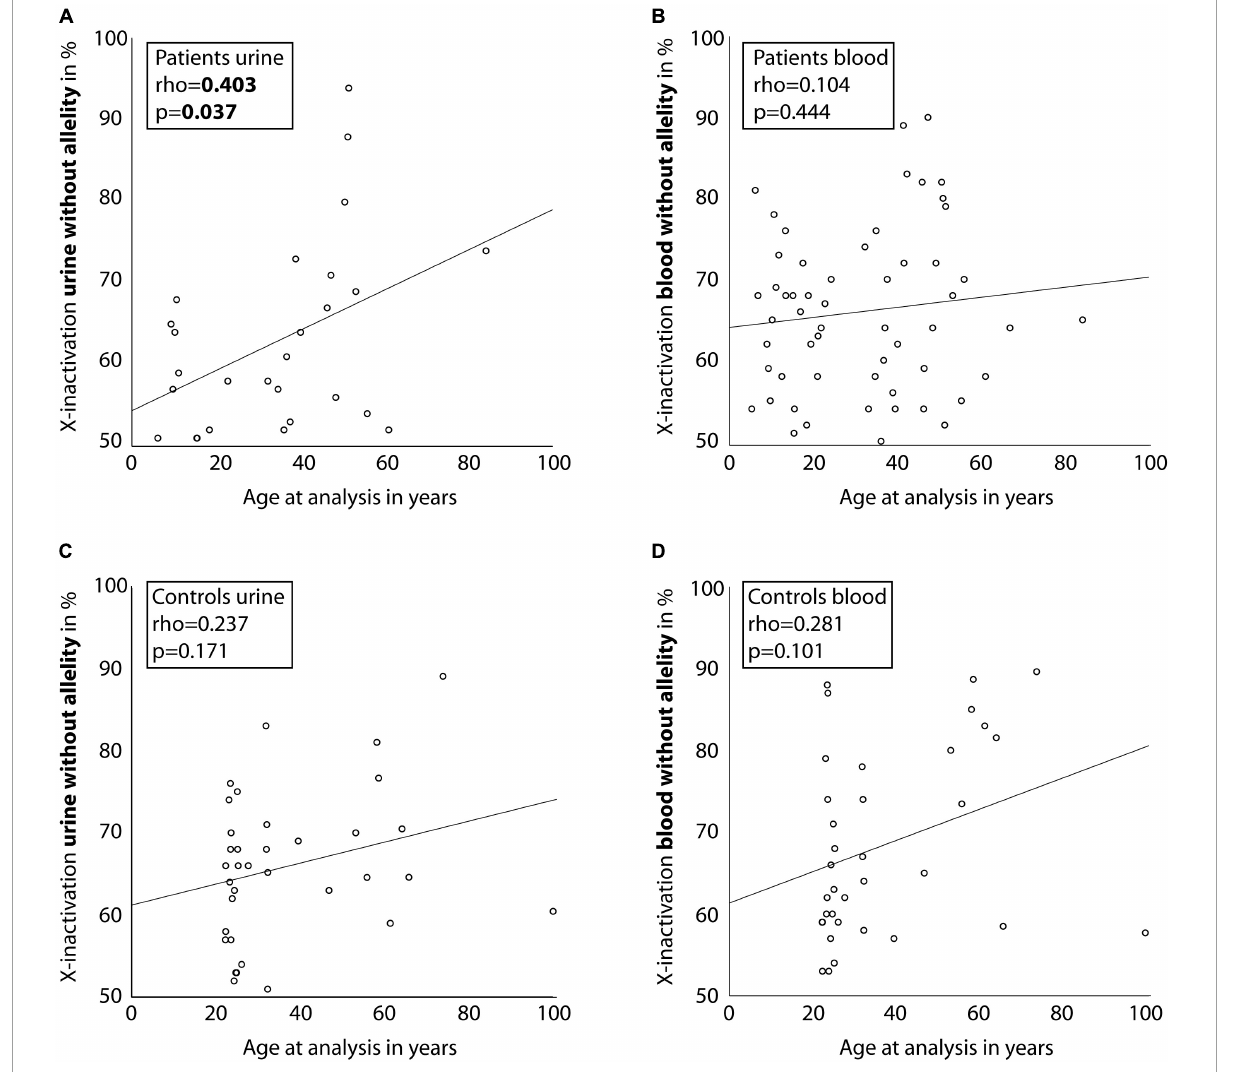
FIGURE3 Correlation between age of individuals and X-inactivation in blood and urine cells. Scatter-dot plots of the association of participant age and X-inactivation in blood and urine cells for individuals with a heterozygous disease-causing COL4A5 variant (A,B) and healthy controls (C,D) . Spearman’s rho was calculated and is displayed in the boxes. Linear regression lines were plotted for illustration